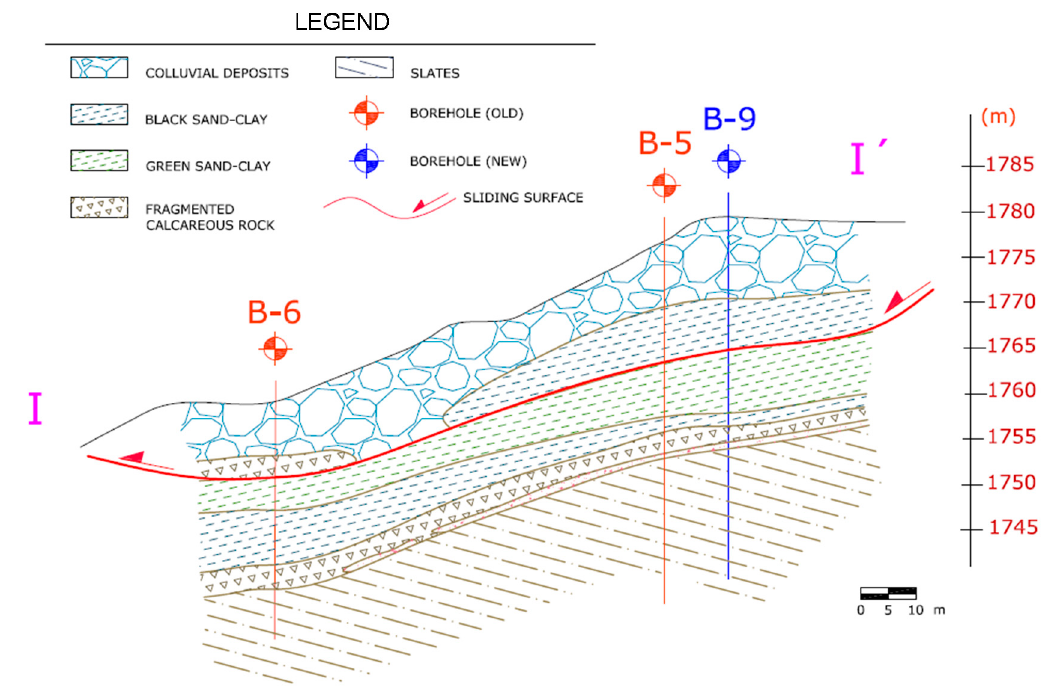
Figure 5. Geotechnical profile I-I ′ (see Figure 2) of the area under study; failure surface detected is shown in red.